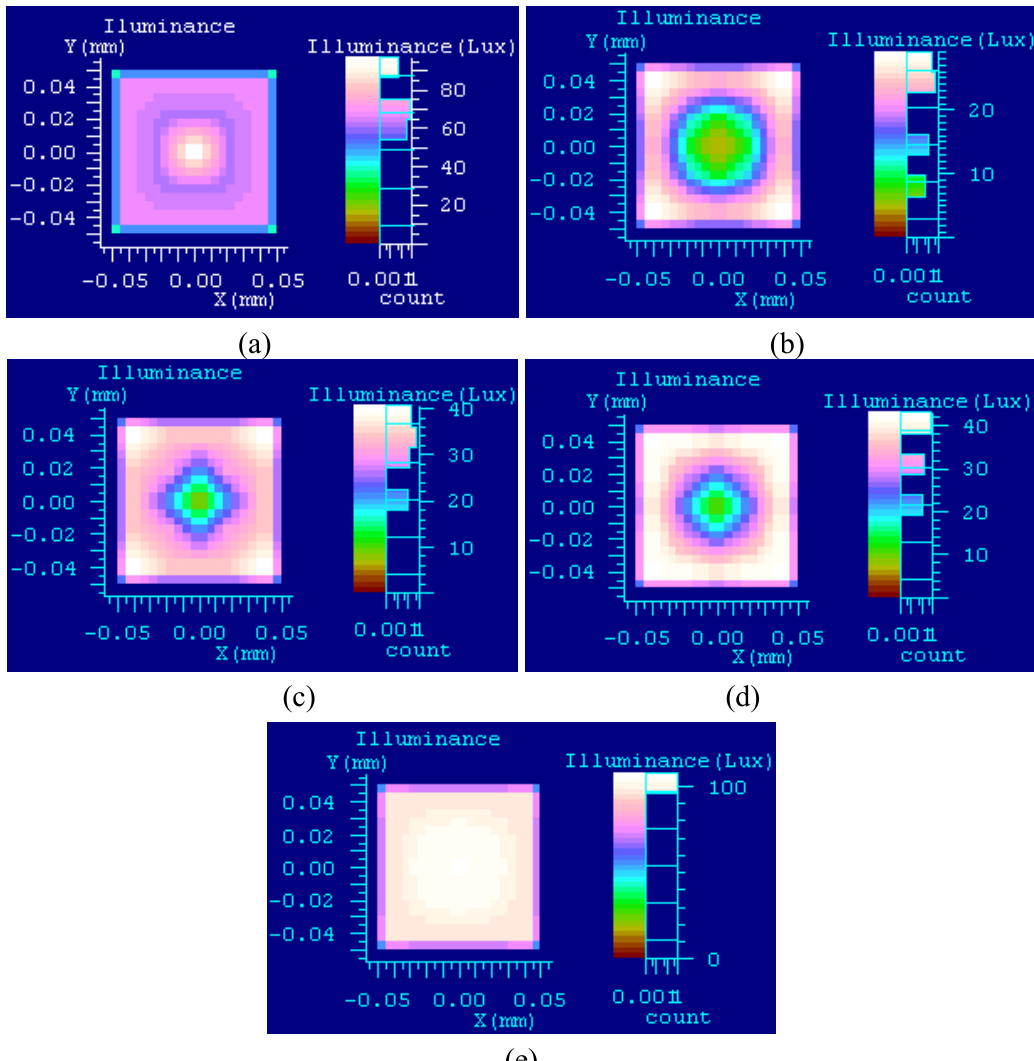
Figure 9. Illumination diagram: (a) coaxial light only; (b) , (c) , (d) ring light only, L is 35 mm, 40 mm, 45 mm in turn; (e) complex illumination.